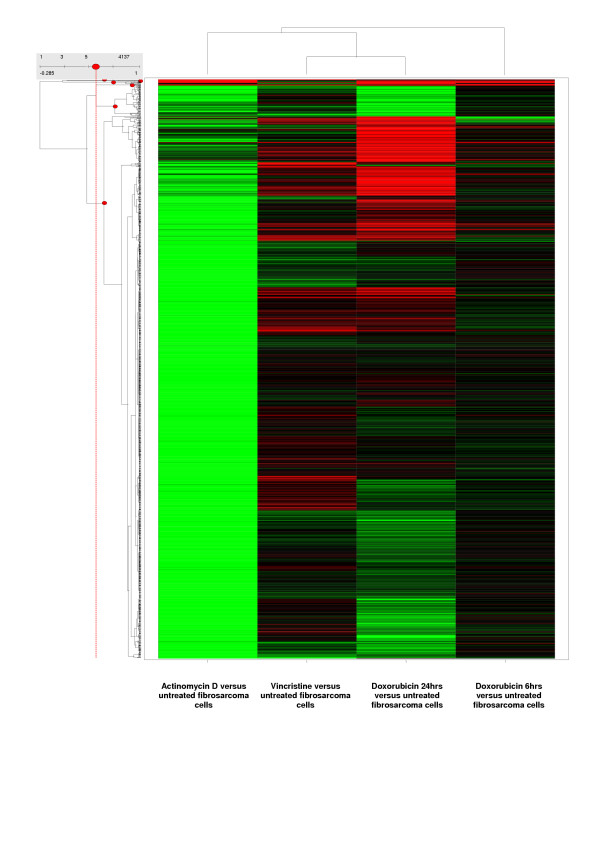
Overall expression patterns of 4137 genes in fibrosarcoma cells treated with doxorubicin (6 h and 24 h), actinomycin D and vincristine (each 24 h). Horizontal rows represent individual genes; vertical columns represent individual samples. Colour range: Brightest red: Signal Log Ratio (SLR)> = 2 (indicates expression level above untreated cells); brightest green: SLR< = 2 (indicates expression level below untreated cells); black: SLR = 0 (indicates unchanged expression). The dendogram at the top of the matrix indicates the degree of similarity between tumor samples; the dendogram at the left side indicates the degree of similarity among the selected genes according to their expression patterns.